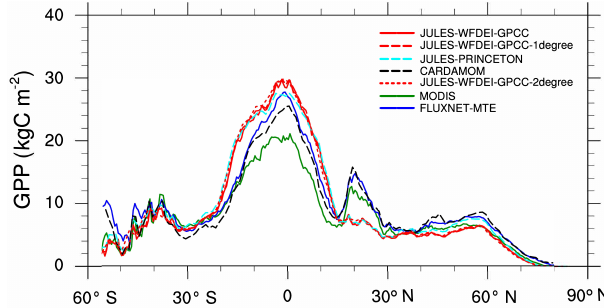
Figure 5. Zonal mean of total annual model-simulated (JULES- WFDEI-GPCC, JULES-WFDEI-GPCC-1degree, JULES- PRINCETON, CARDAMOM and JULES-WFDEI-GPCC- 2degree) and observed (FLUXNET-MTE and MODIS) GPP fluxes for 2001–2010. JULES-WFDEI-GPCC, FLUXNET-MTE and MODIS are at 0 . 5 ◦ × 0 . 5 ◦ spatial